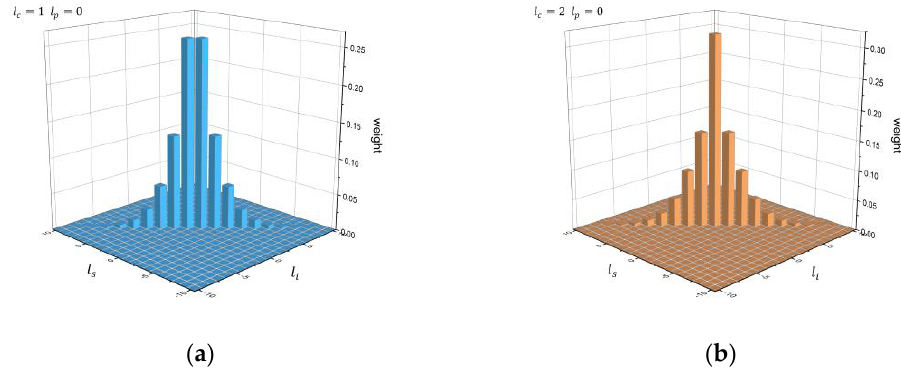
Figure 2. The incident light is a Gaussian mode. ( a ) The normalized spiral spectrum with l c = 1. ( b ) The normalized spiral spectrum with l c =